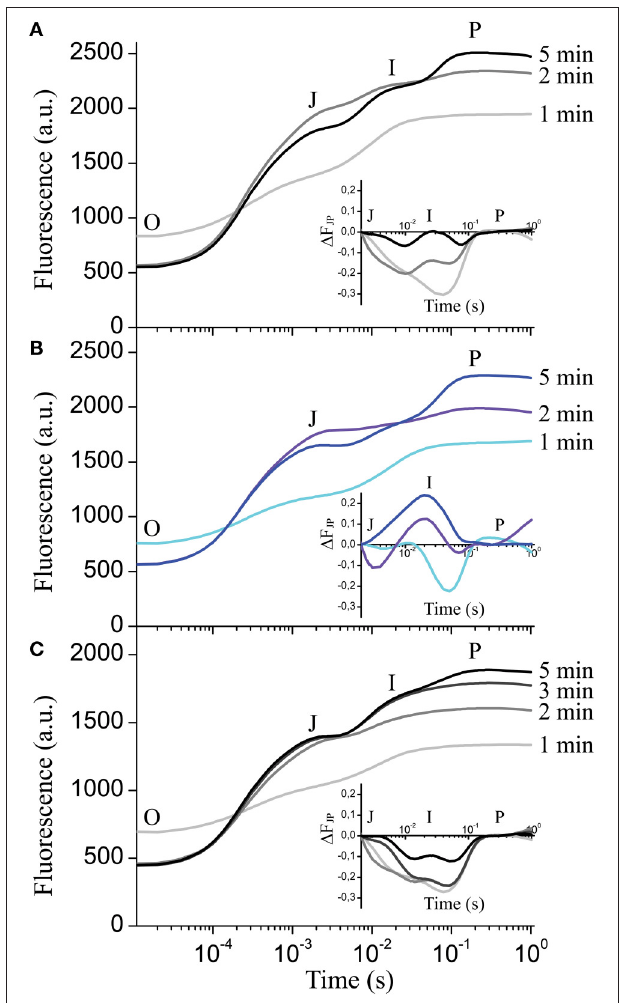
FIGURE 6 | Effect of dark adaptation interval on the fast chlorophyll a fluorescence OJIP transients. OJIP transients were recorded on leaves of wild-type (A) and mutant plants (B) , following the indicated dark adaptation intervals. Insets show the curve difference ( 1 F JP ) of double normalized data at J (2ms) and P, between 15min dark adapted wildtype and 1, 2, and 5min dark adapted wildtype (A) or clce-2 (B) . (C) OJIP transients were recorded on wild-type leaves pre-incubated with 150mM KCl in the light followed by the indicated dark adaptation intervals. Inset shows the curve difference ( 1 F JP ) of double normalized data at J and P between 15-min dark-adapted KCl-treated wildtype and 1, 2, 3, and 5-min dark-adapted KCl-treated wildtype. The plotted transients are means ± SEM ( n = 5